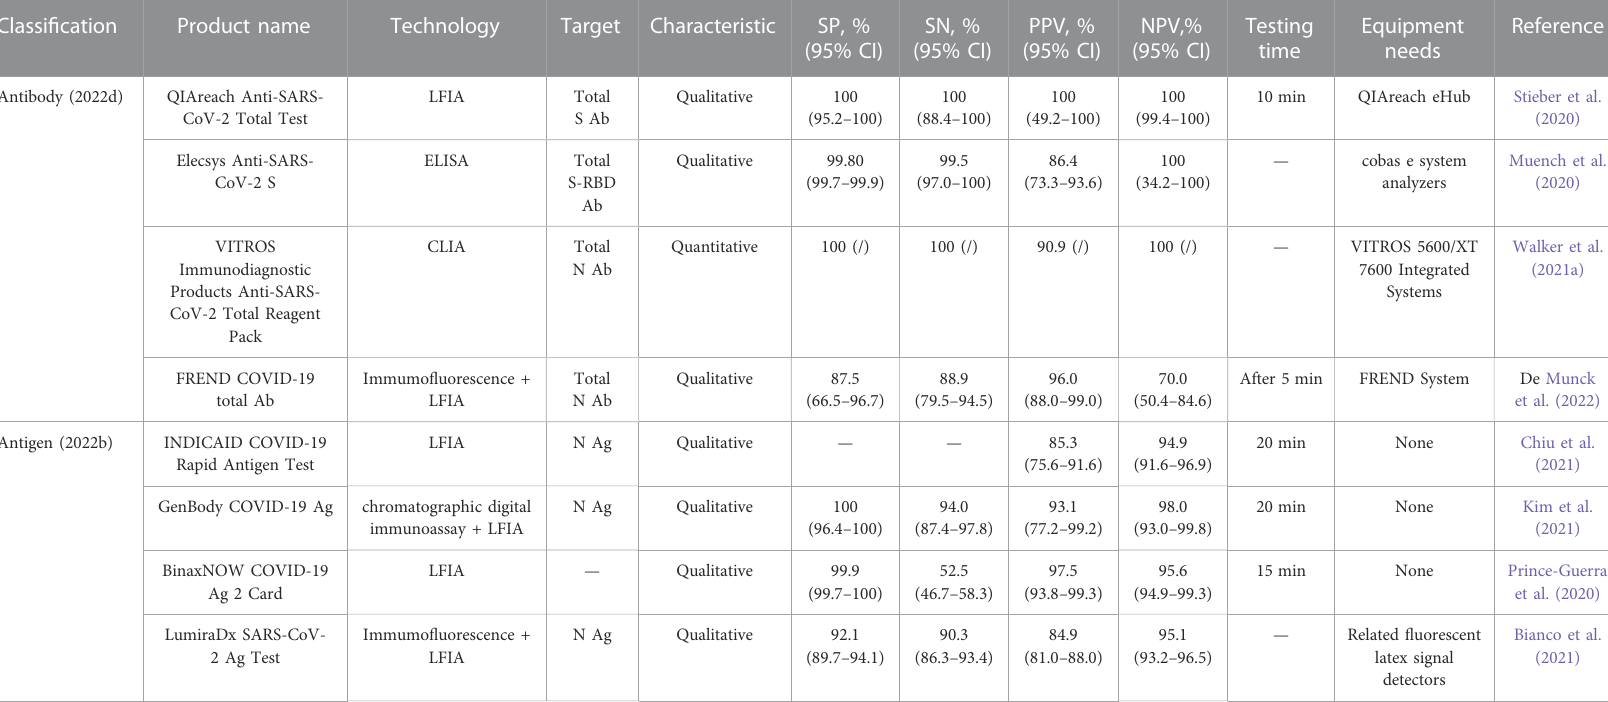
TABLE 1 Comparison of the performance of some of the LFIC test strips authorized for antibody and antigen detection by the U.S. Food and Drug Administration emergency